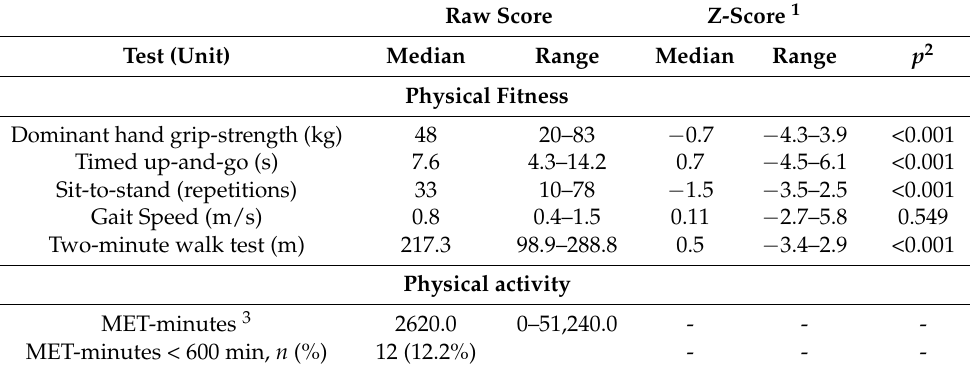
Table 3. Physical fitness and activity of the long-term HSCT survivors ( n = 97) compared to normative reference